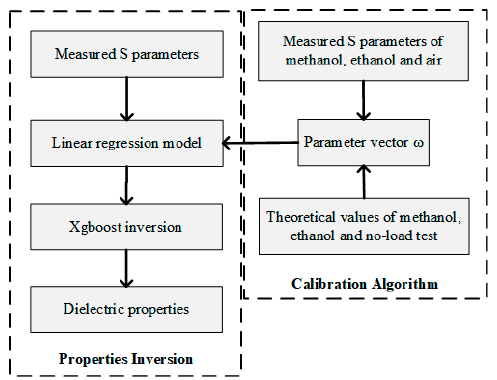
Figure 7. The schematic diagram of system calibration.